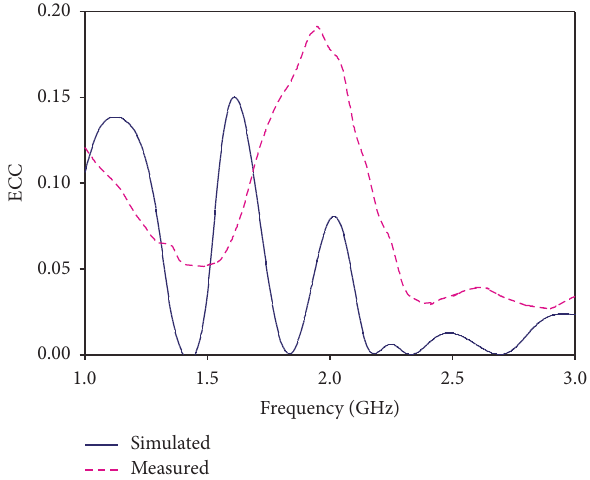
Figure 15: Simulated and measured envelope correlation coefficient for first